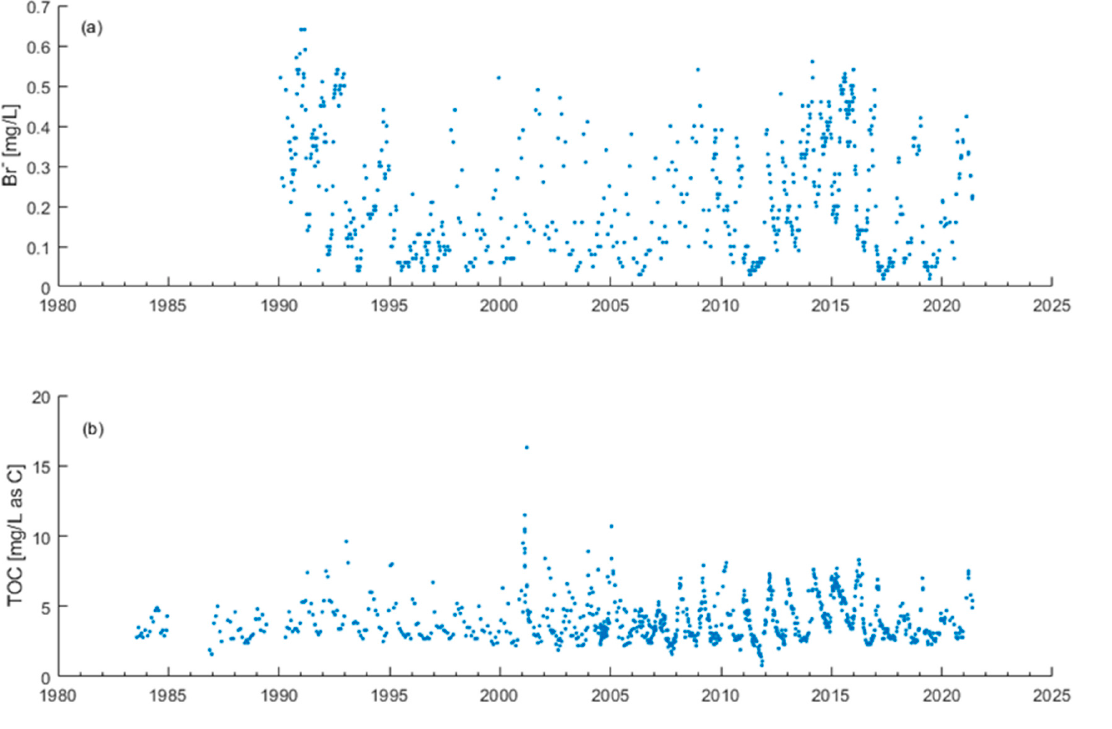
Figure 3. Representative data from the MWQI Program at the Banks Station: ( a ) Bromide (Br − ) and ( b ) TOC. Data are downloaded from the California Water Data Library (WDL Water Quality Data (ca.gov), accessed 21 July 2021).